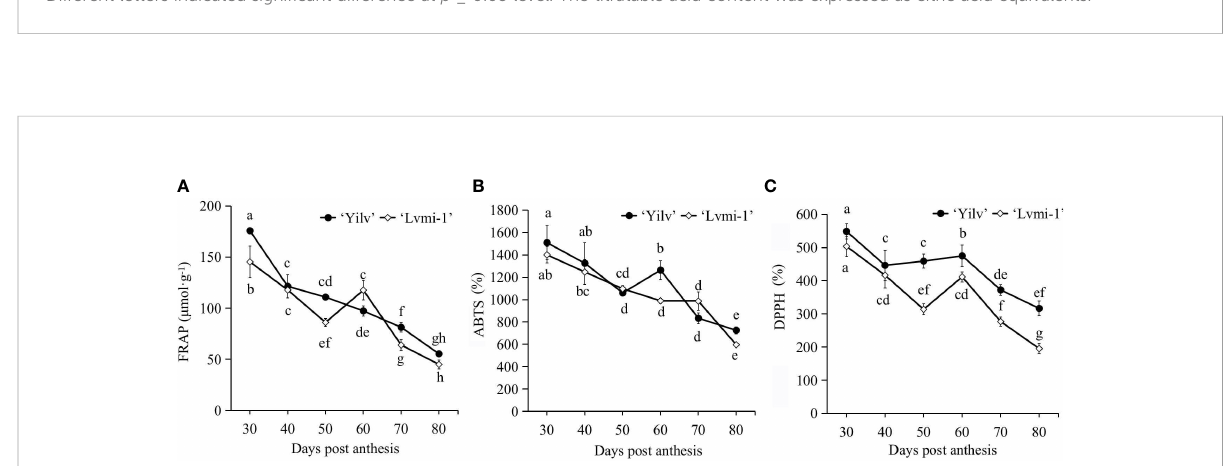
FIGURE 3 Changes of antioxidant activity of ‘ Yilv ’ and ‘ Lvmi-1 ’ fruits during fruit development and maturity. (A) Ferric reducing antioxidant power, FRAP. (B) 2,2 ’ -Azino-bis (2-ethylbenzothizoline-6-sulfonic acid), ABTS. (C) 2,2-Diphenyl-1-picrylhydrazyl radical, DPPH. Data were represented by the mean values ± standard deviation. Different letters indicated signi fi cant difference at the p ≤ 0.05